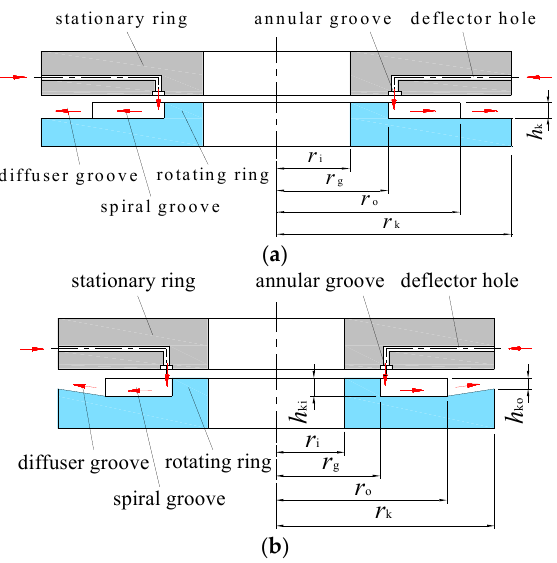
Figure 2. The diffuser groove structure: ( a ) The flat-bottomed equal cross-sectional diffuser groove; ( b ) The conical convergent diffuser groove.